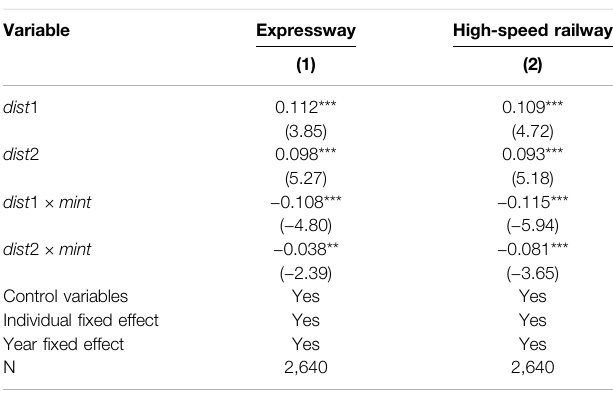
TABLE 5 | Results of robustness tests